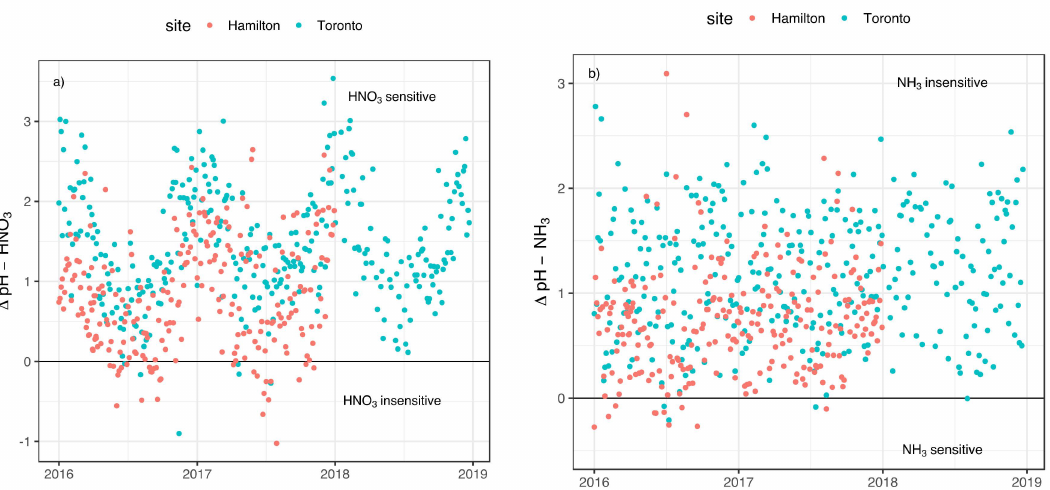
Figure 5. Time series of calculated ∆ pH for ( a ) HNO 3 , and ( b ) NH 3 in Hamilton (red) and Toronto (light